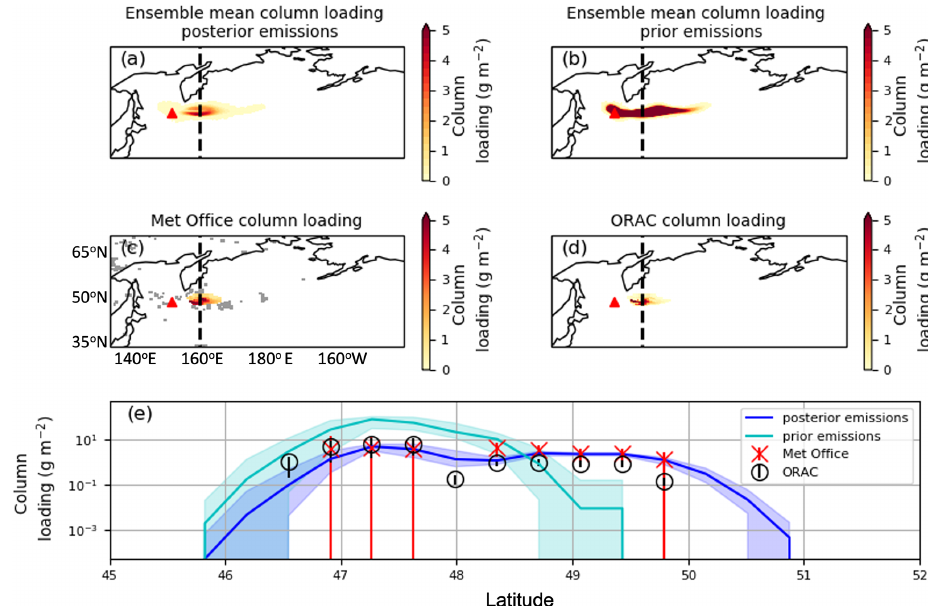
Figure 6. (a) Ensemble mean ash column loading for simulations runs with emission profiles determined using InTEM with matching ensemble meteorology at 12:00UTC 22 June 2019; (b) ensemble mean ash column loading at 12:00UTC 22 June 2019 for simulations runs with prior emission profile and ensemble meteorology; (c) Himawari ash column loading retrieved using the Met Office algorithm (grey shading indicates grid boxes that are classified as clear sky); (d) Himawari ash column loading retrieved using the ORAC algorithm for 12:00UTC 22 June 2019; (e) ash column loading profile from 45–52 ◦ N along the cross section indicated by the black dashed line in panels (a–d) . Posterior ensemble (blue), prior ensemble (cyan), Himawari ash column loading retrieved using the Met Office algorithm (red crosses) and Himawari ash column loading retrieved using the ORAC algorithm (black circles). The error bars represent ± 1 standard deviation in the estimates of ash column loading determined from the satellite retrievals. The coloured shading indicates the range of column loading in the ensemble.